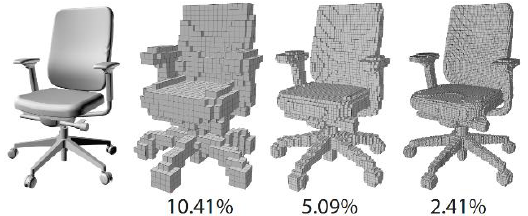
Figure 1. The percentage of occupied grids in different grid resolutions. The percentage at resolution 30 3 is 10.41% and reduced to 5.09% and 2.41% at resolution 64 3 and 128 3 , respectively. (Li et al.,